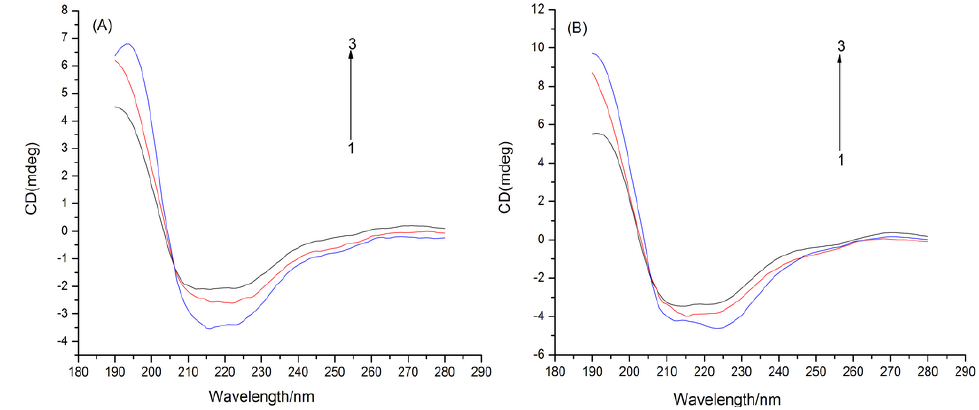
Figure 4. CD spectra of puerarin–CYPs in the absence and presence of increasing amount of puerarin (concentrations of puerarin (1 → 3): 0, 8 × 10 − 4 and 9 × 10 − 4 mol L − 1 ).